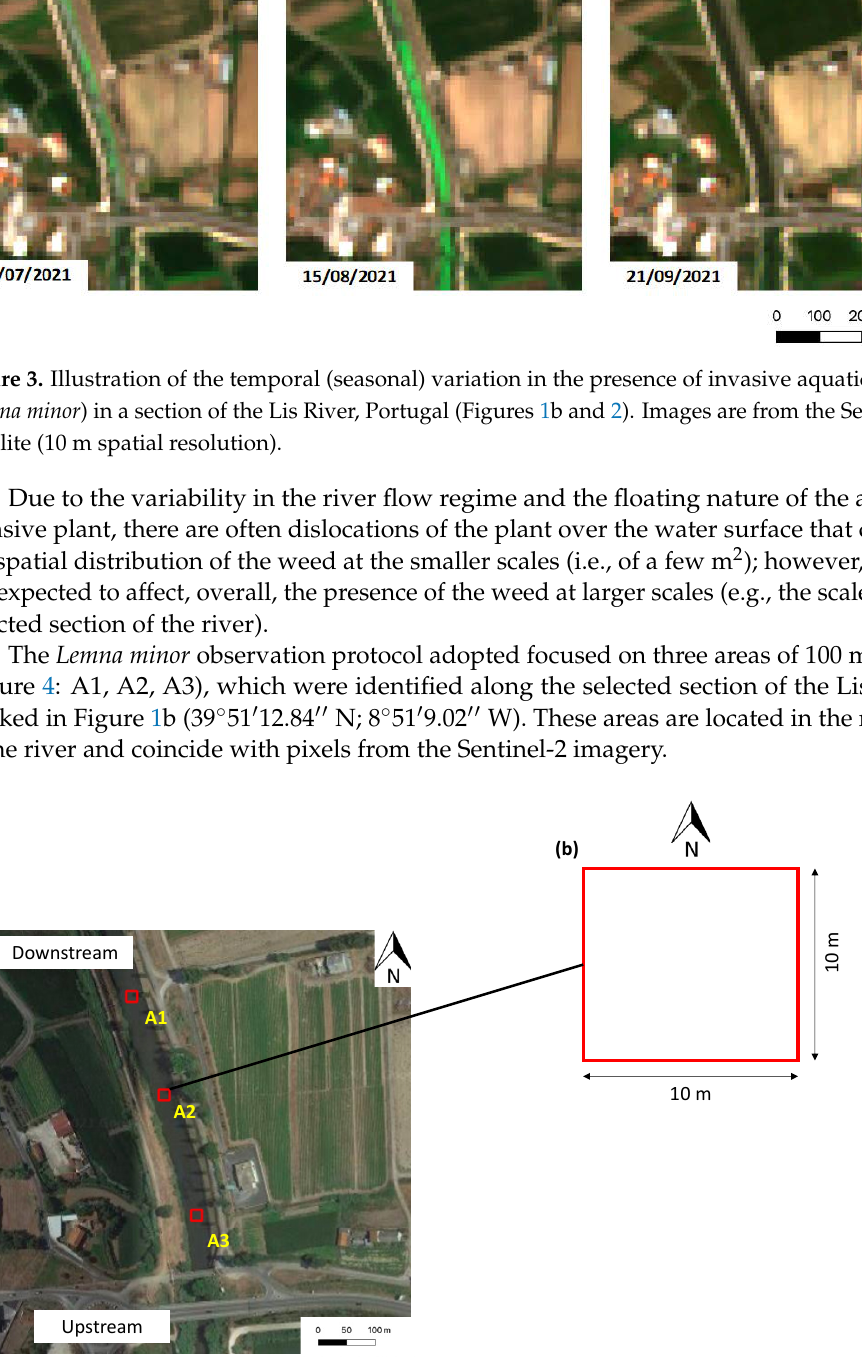
Figure 4. Observing the invasive aquatic plant Lemna minor in a section of the Lis River, near Monte Real (Portugal): ( a ) Location of the three sample areas (red squares: A1, A2, A3; markers are not to scale) on the river water surface. ( b ) Diagram of a typical quadrangular sample area, of 100 m 2 .